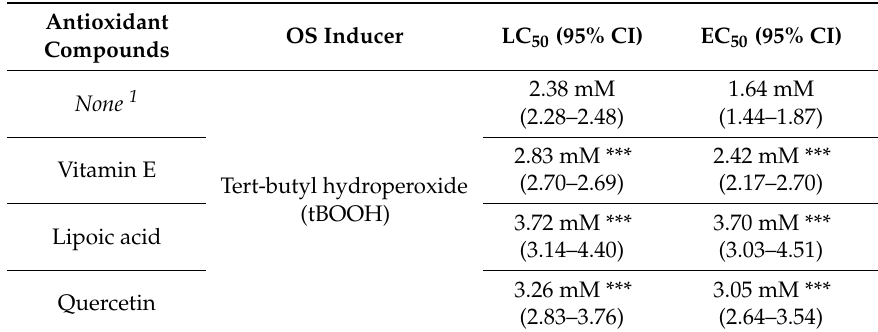
Table 3. E ff ects of antioxidant compounds in lethality and dysmorphogenesis of zebrafish embryos exposed to